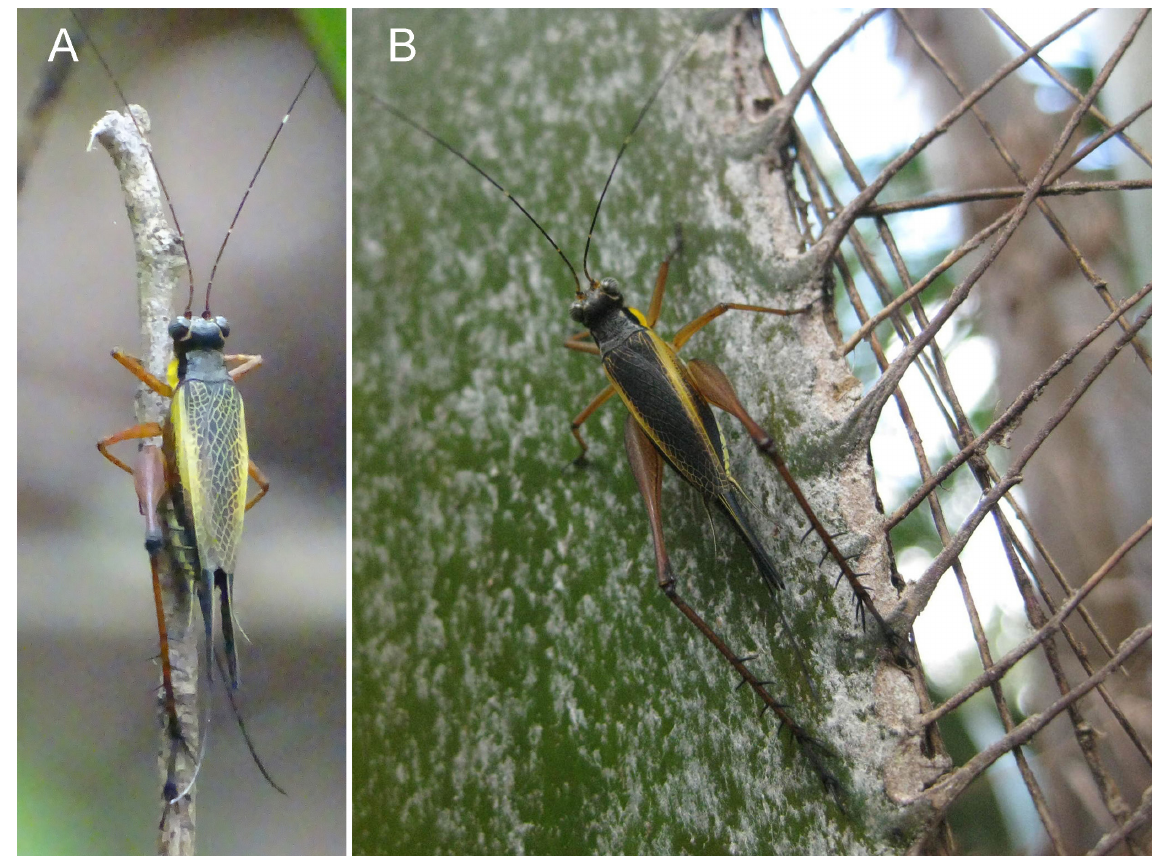
Fig. 18. Nisitrus brunnerianus Saussure, 1878. A . In its natural environment. B . In an oil palm plantation. Photograph source and credits: iNaturalist; James Steamer (A), Ganjar Cahyadi